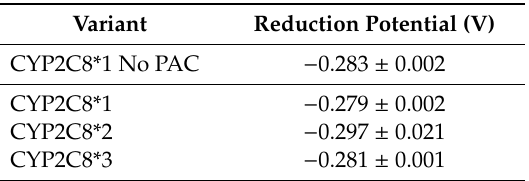
Figure 4. Reduction potential of CYP2C8 variants. Redox titration of CYP2C8 variants was conducted in 0.1 M phosphate buffer (pH 7.4 at 25 °C) with or without 70 µM PAC. The potential was measured spectroscopically by using a safranin T as the redox indicator. Reduction was achieved using light and dithionite and oxidation was achieved using K 3 [Fe(CN) 6 )] as stated in the Methods section. Representative Nernst plots for ( A ) CYP2C8*1 without paclitaxel (open black) and with paclitaxel (solid black), ( B ) CYP2C8*2, and ( C ) CYP2C8*3 from two experiments are shown. Data obtained from reduction is given as squares and data from oxidation is given as triangles. The zero intercept gives E °′, the redox potential of the protein. Table 3. Reduction potentials. Reduction potentials of the CYP2C8 variants was determined as described in the text. Error represents the SEM of two experiments.